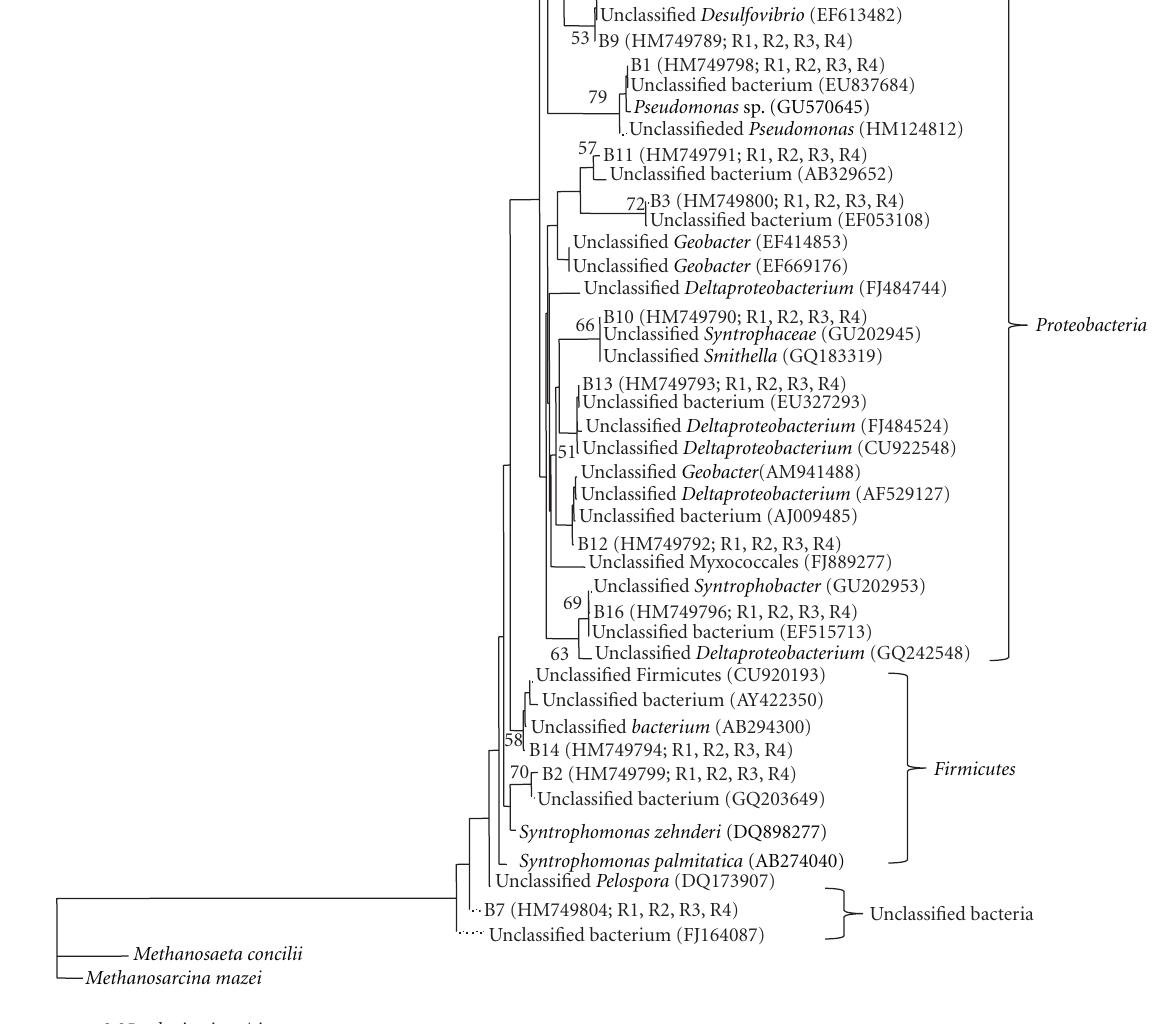
Figure 3: Phylogeny of bacterial sequences obtained by DGGE from R1–R4 biomass, calculated using the Kimura-2 algorithm and the neighbour-joining method [23]. Bootstrap replicates (total 100 replicate samplings) supporting the branching order are shown at relevant nodes. Accession numbers and the bioreactor biomass containing the respective bands are given in parenthesis. R1: 37 ◦ C TCE-supplemented; R2: 37 ◦ C control; R3: 15 ◦ C TCE-supplemented; R4: 15 ◦ C